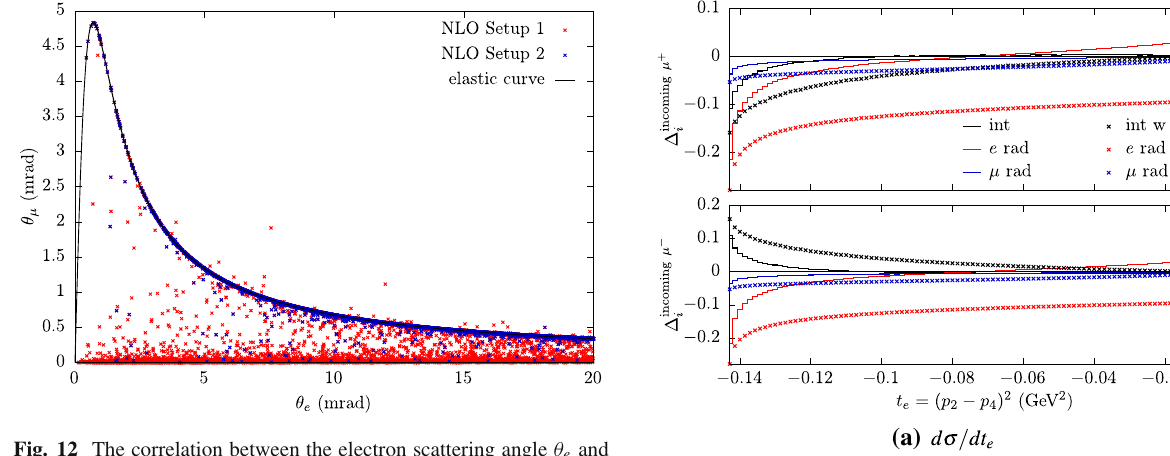
Fig. 12 The correlation between the electron scattering angle θ e and muon scattering angle θ μ for the μ + e − → μ + e − process at LO (elastic curve) and NLO QED, for the selection criteria 1 and 2 defined in the text